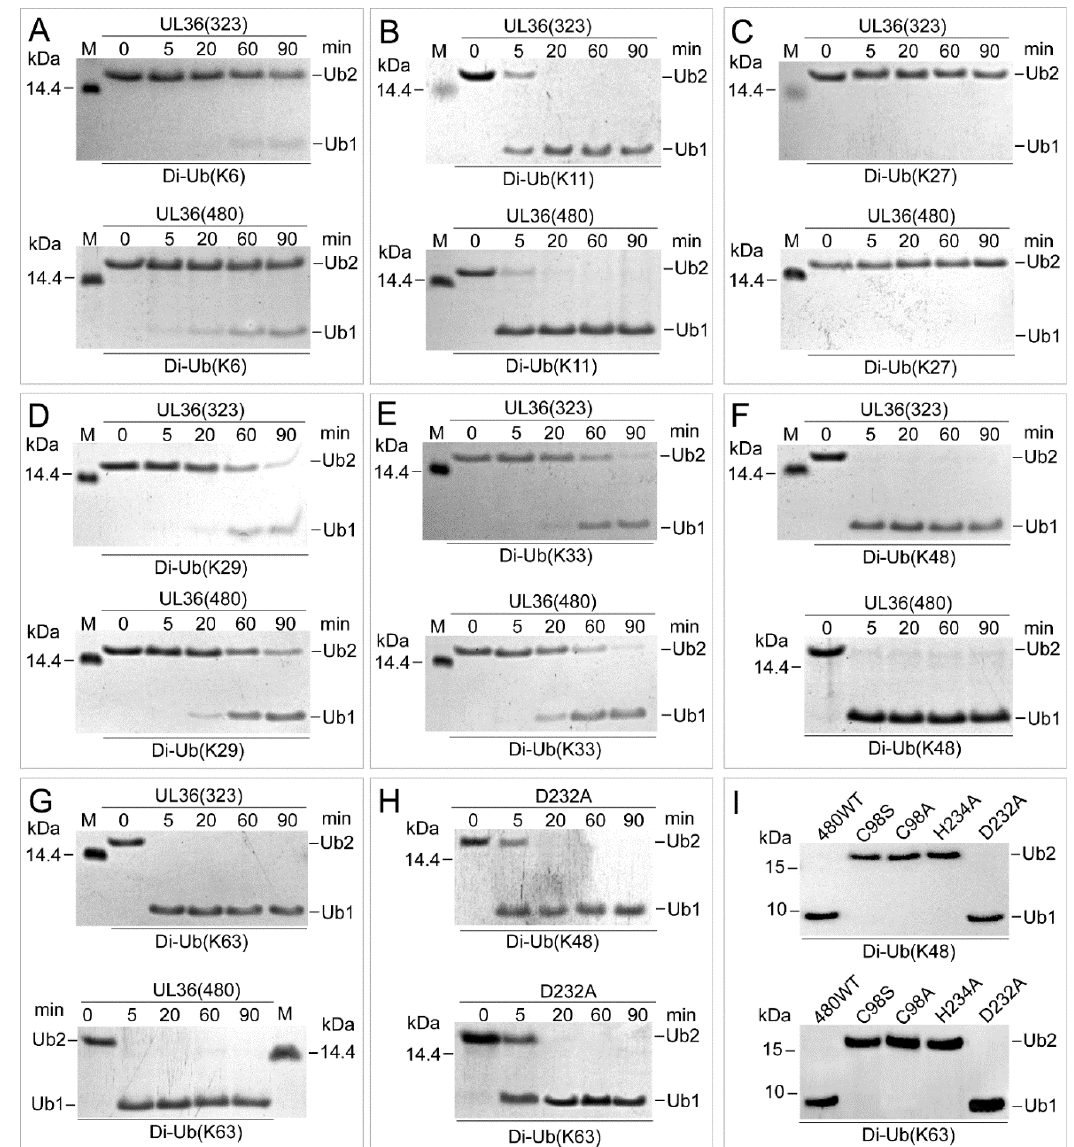
Figure 3. Characterization of ubiquitin (Ub) linkage preference of UL36(323) and UL36(480). (A − G) SDS-PAGE images of UL36-DUBs digestion products on various types of dimeric Ub chains. (H) SDS-PAGE images of the products of UL36(480) D232A hydrolyzing K48 and K63 linkage Ub chains. (I) Western blotting of digestion products of wild type 36 on K48 and K63 linkage Ub chains after a 90-min incubation. The labels under each image indicate different types of Ub linkage dimer. Labels on the sides of each picture represent different lengths of Ub; Ub2, Ub dimer; Ub1, Ub monomer. The numbers (0, 5, 20, 60, and 90) on the top of the images (A − H) indicate the incubation time in minutes. In (H) and (I) , 480WT, wild type UL36(480); C98S, C98A, H234A, and D232A indicate UL36(480) C98S , UL36(480) C98A , UL36(480) H234A , and UL36(480) D232A mutants, respectively. M in images A − G labels the protein standard.